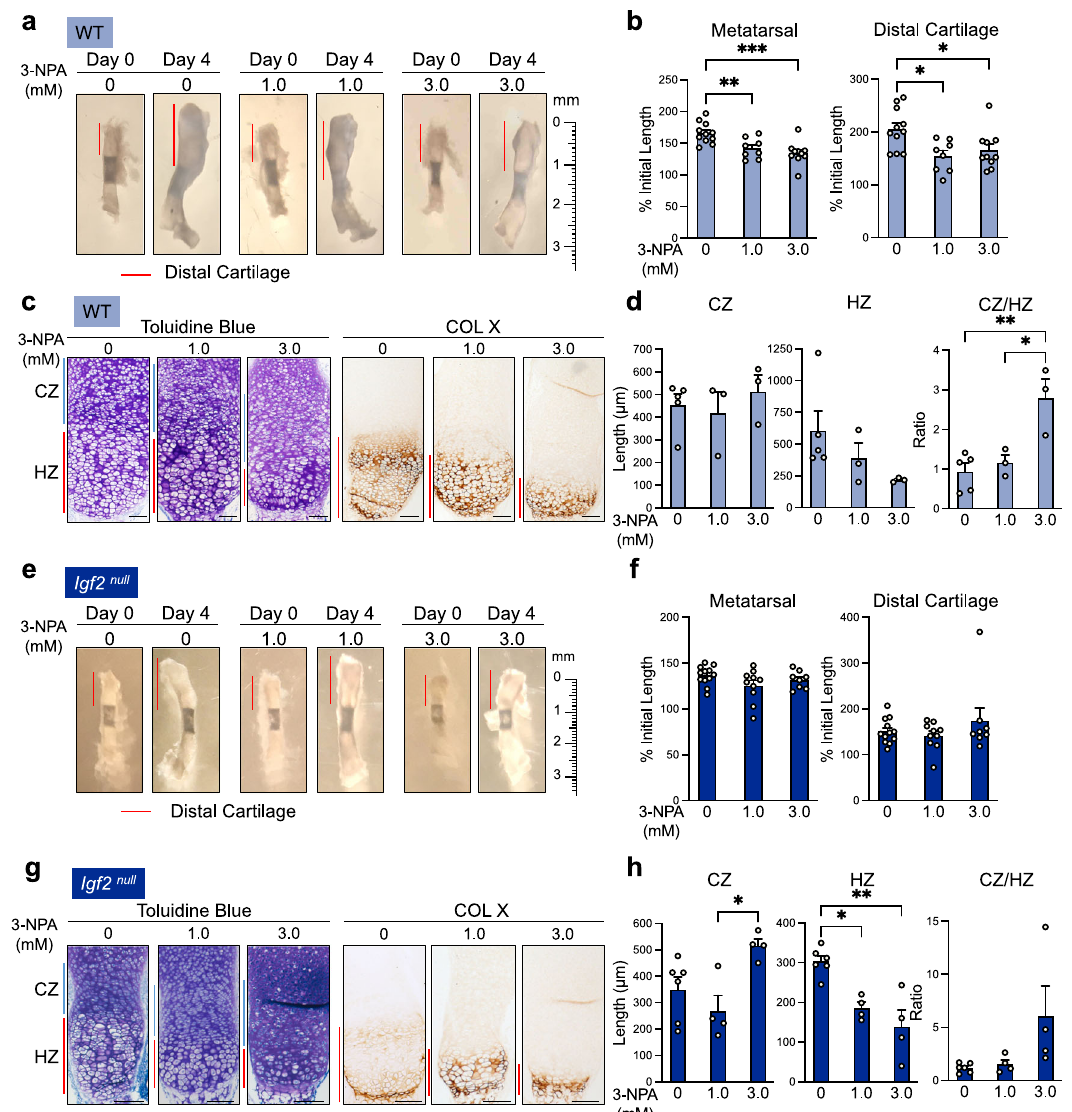
Fig. 5 Inhibition of oxidative phosphorylation in ex vivo metatarsal culture does not alter bone growth, but increases the length of the columnar zone at the expense of the hypertrophic zone. a Images of WT metatarsal explants cultured for 4 days with and without 3-NPA. Representative of n = 8 – 11 bones per group. b Quanti fi cation of metatarsal and distal cartilage growth from the beginning of the culture period (as percent of initial length of metatarsal or distal cartilage). n = 8 – 11 bones per group. c Toluidine blue staining and collagen X (hypertrophic marker) IHC on ex vivo-cultured WT metatarsals treated with 3-NPA. Representative of n = 3 – 5 bones per group. CZ columnar zone. HZ hypertrophic zone. d Measurements of the lengths of the CZ and HZ, and the ratio of the CZ to the HZ, in ex vivo-cultured WT metatarsals treated with 3-NPA. n = 3 – 5 bones per group. e Igf2 null metatarsal explants cultured for 4 days with and without 3-NPA. Representative of n = 8 – 12 bones per group. f Quanti fi cation of metatarsal and distal cartilage growth from the beginning of the culture period (as percent of initial length of metatarsal or distal cartilage). n = 8 – 12 bones per group. g Toluidine blue staining for morphology and IHC for collagen X (hypertrophic marker) in Igf2 null metatarsals treated with 3-NPA. Representative of n = 4 – 6 bones per group. CZ columnar zone. HZ hypertrophic zone. h Measurements of the lengths of the CZ and HZ, and the ratio of the CZ to the HZ, in Igf2 null metatarsals treated with 3-NPA. n = 4 – 6 bones per group. Scale bar: 100 µ m. Data are presented as individual measurements with mean + SEM. Note that the control data (0 mM 3-NPA) for b , d , f , and h are also shown in Fig. 7. Statistical signi fi cance was calculated one-way ANOVA with Sidak ’ s test for multiple comparisons ( b , d , f , h ). p -values indicated as * p < 0.05, ** p < 0.01, *** p <